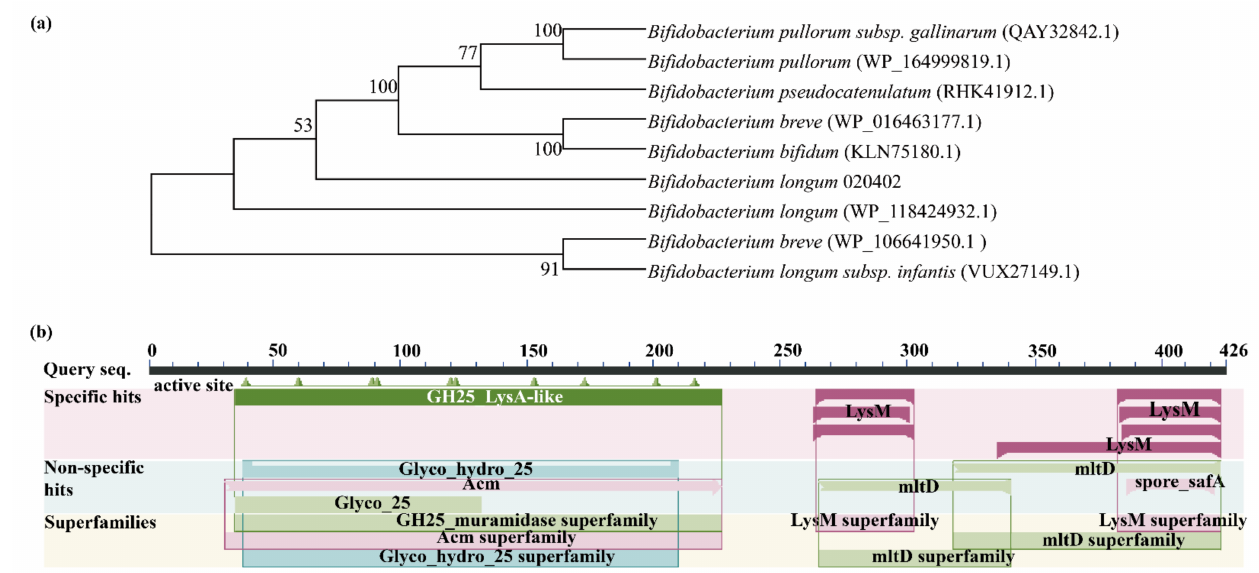
Figure 1. Homology and functional prediction of lysozyme-like protein. ( a ) Phylogenetic tree of lysozyme-like protein sequence. ( b ) Conserved domains of lysozyme-like